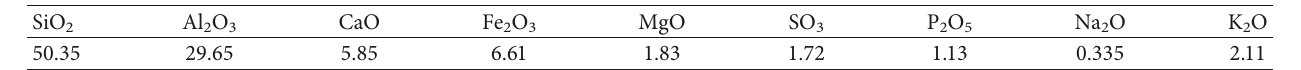
Table 2: Chemical composition of Class III fly ash.